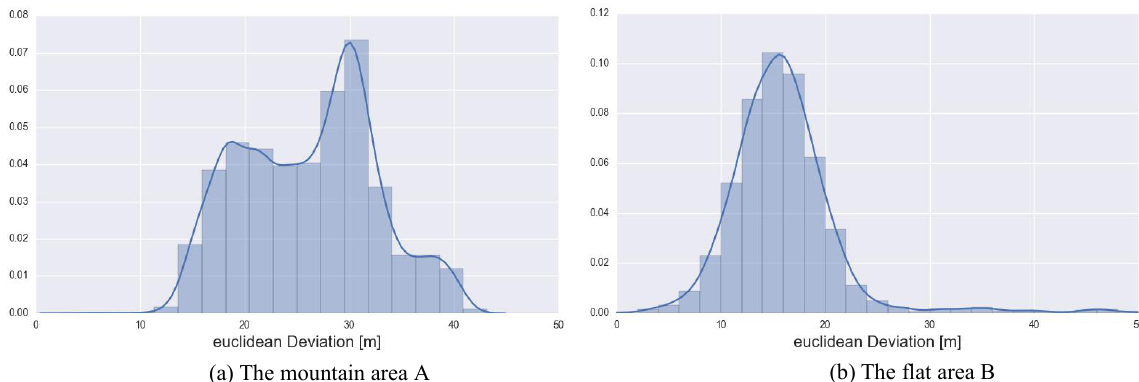
Figure 3. The normalized histograms of the euclidean deviations of checking points